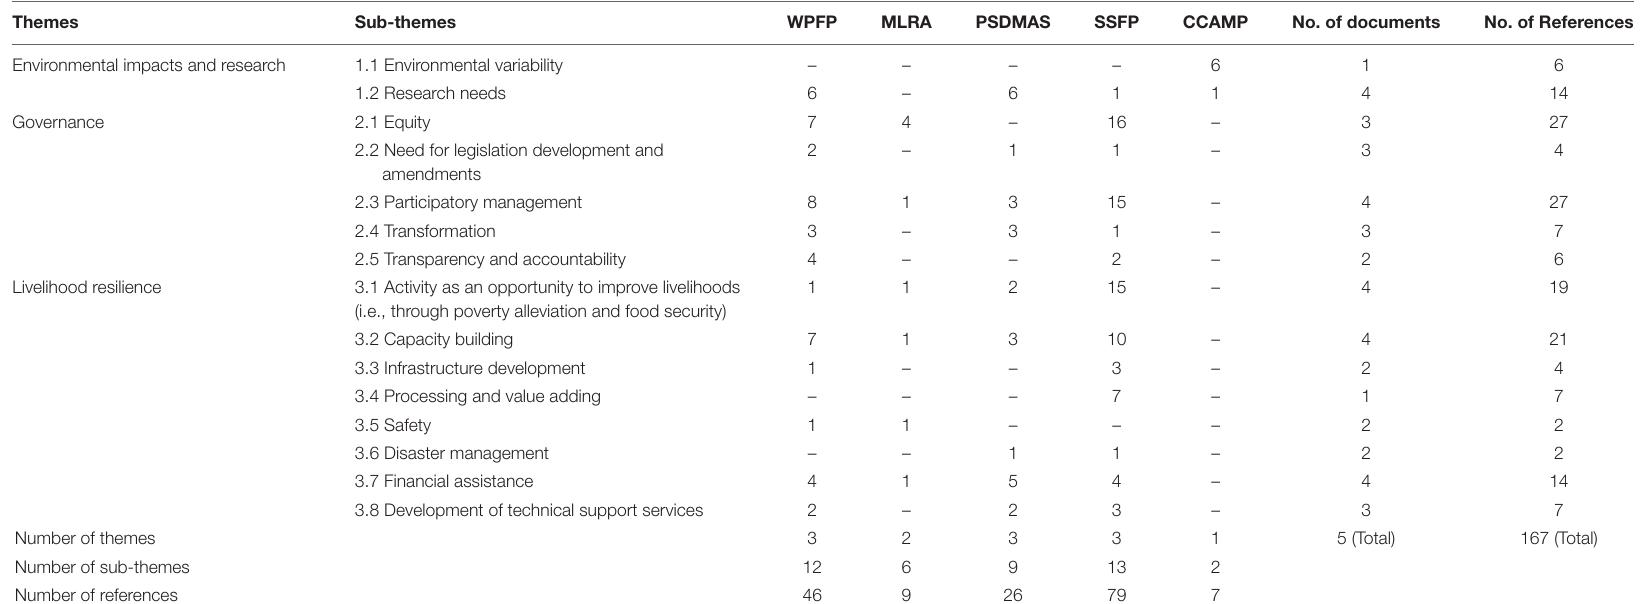
TABLE 6 | Number of indirect climate references identified in the content analysis of fisheries